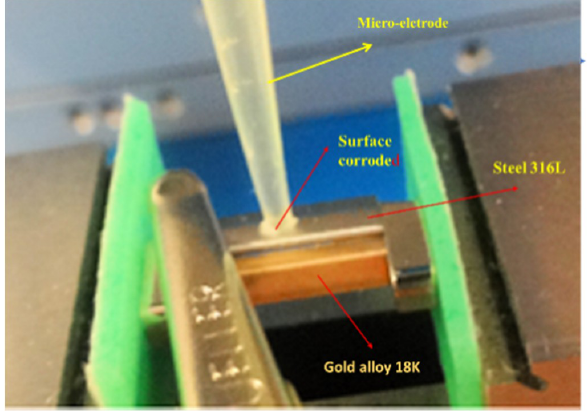
Figure 3. Measurement by microelectrode technique on the steel part of the bracelet.